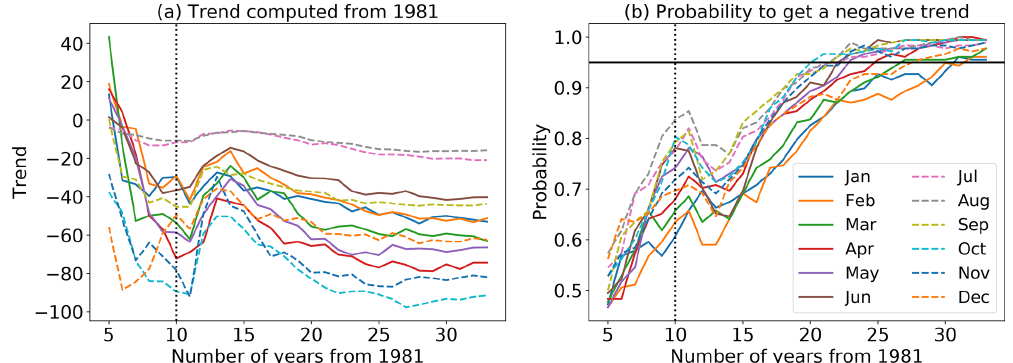
Figure 7. (a) Northern Hemisphere monthly trends of snow extent in CMIP6 models over 1981–2014 computed with 178 members from 21 CMIP6 models as a function of the number of years from 1981 and starting from a 5-year time series. (b) Probability of negative monthly trends estimated from the full ensemble members. The horizontal bar highlights a probability of 95%, and the vertical bars correspond to the year of the Pinatubo